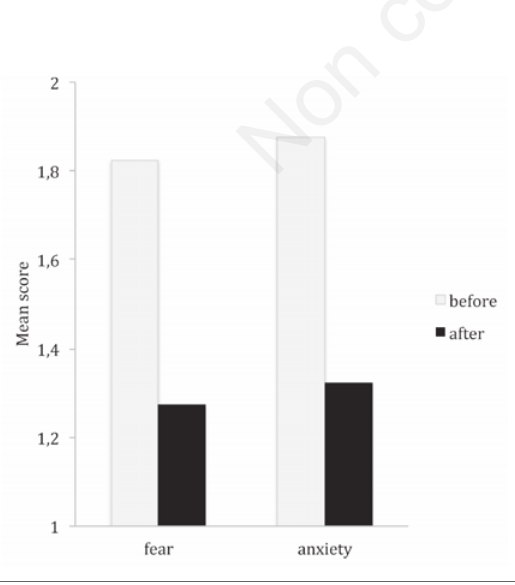
Figure 1. Average scoring, for fear and anxiety, obtained by experimental group before and after the psychological interven- tion.